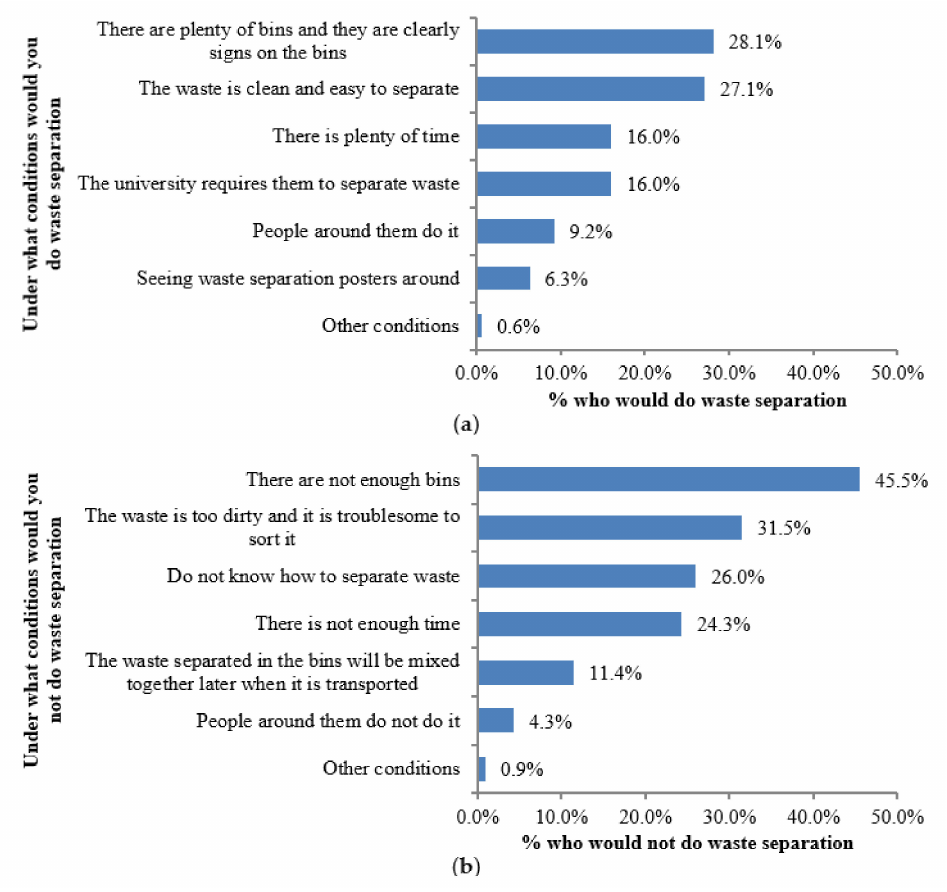
Figure 2. Conditions under which respondents would do / not do waste separation (N = 1204). ( a ) Conditions under which respondents would do waste separation. ( b ) Conditions under which respondents would not do waste